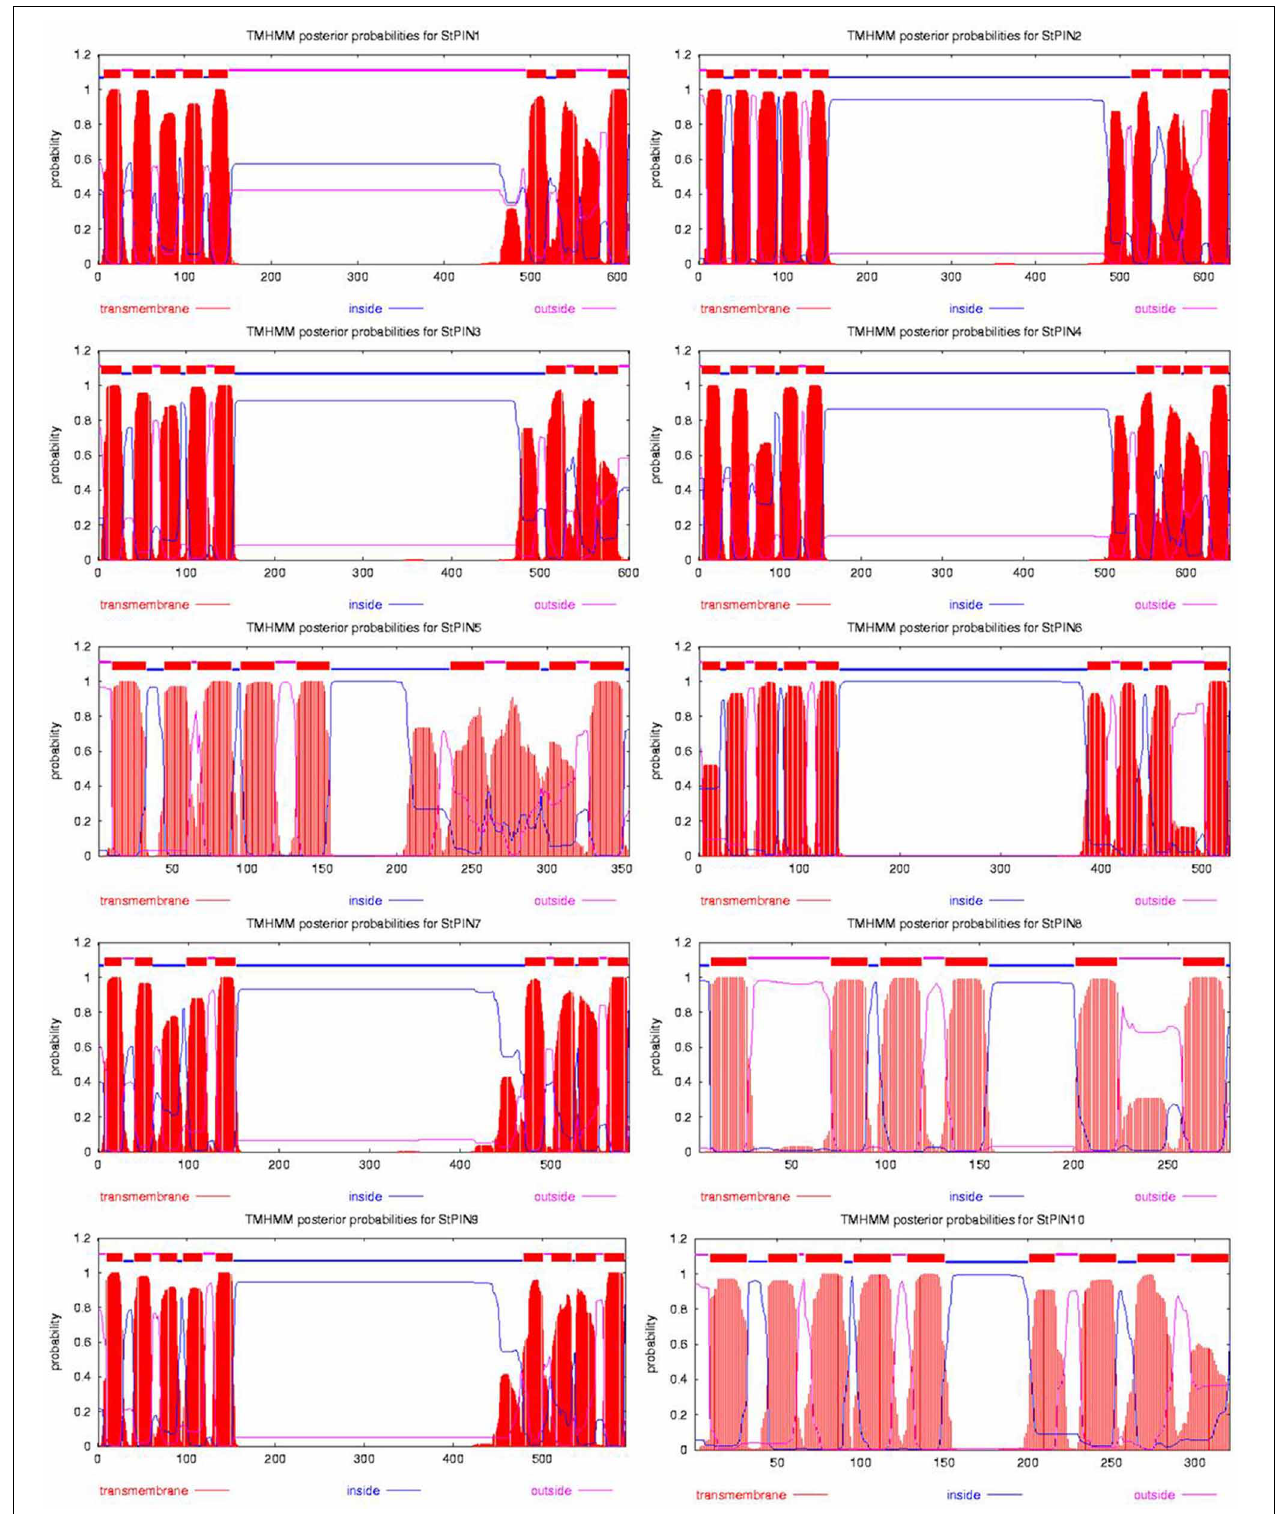
FIGURE 2 | Hydropathy analysis of the 10 StPIN proteins found in the potato genome. Red peaks and blocks represent the trans-membrane domains, pink lines the areas of the proteins predicted to be outside the cell, and the blue lines represent the areas of the proteins predicted to be inside the cell.